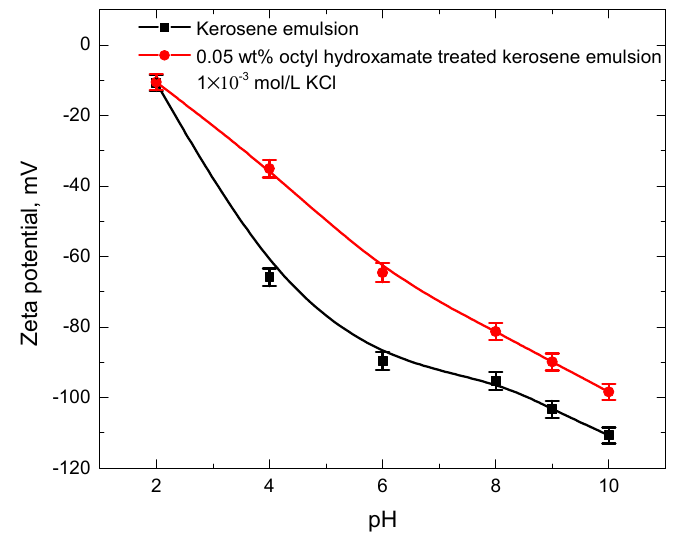
Figure 7. Zeta potential of malachite in the presence and absence of 2 × 10 − 4 mol/L octyl hydroxamate.